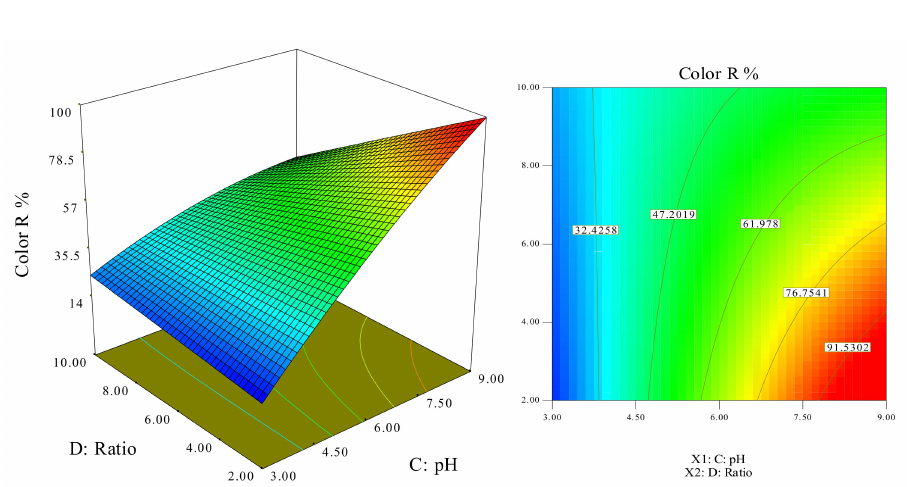
Figure 10. Role of pH and H 2 O 2 :Fe 2+ ratio in leachate decolorization depicted in 3D response surfaces and contour